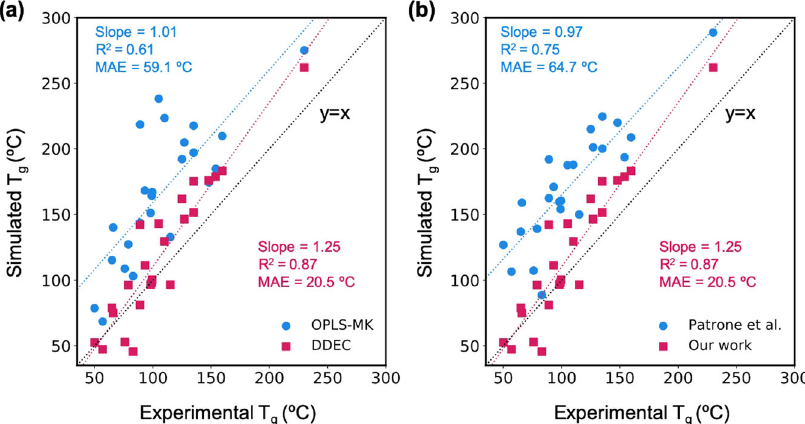
Fig. 4 Comparison between experimental and computational T g values. The experimental and simulated T g of 24 compounds (removing outliers MTDATA and 2-TNATA). a Simulated T g calculated using different MD data (OPLS-MK vs DDEC6; see Methods) and the same fi tting